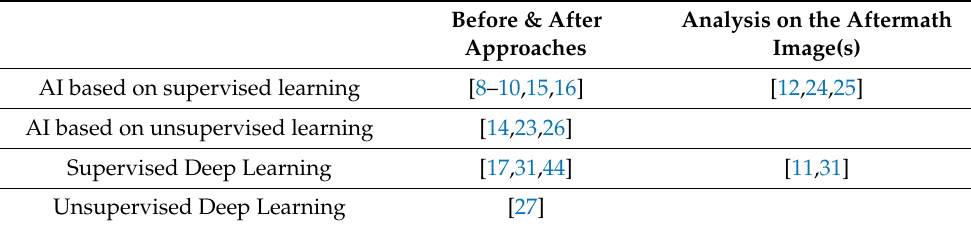
Table 2. The different studies and methodologies used on the Tohoku tsunami images, sorted by category. The Image Processing line is not considered AI in this